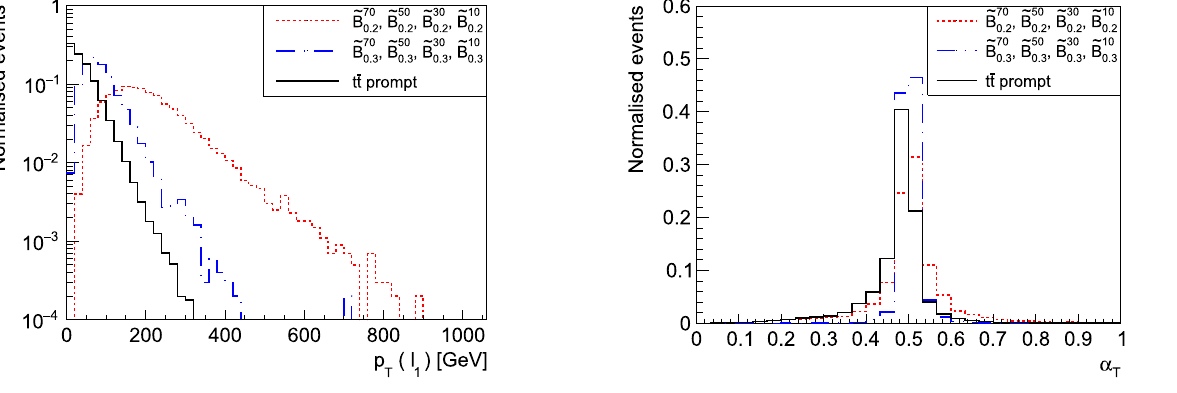
Fig. 24 α T distributions in the ˜ B -like case